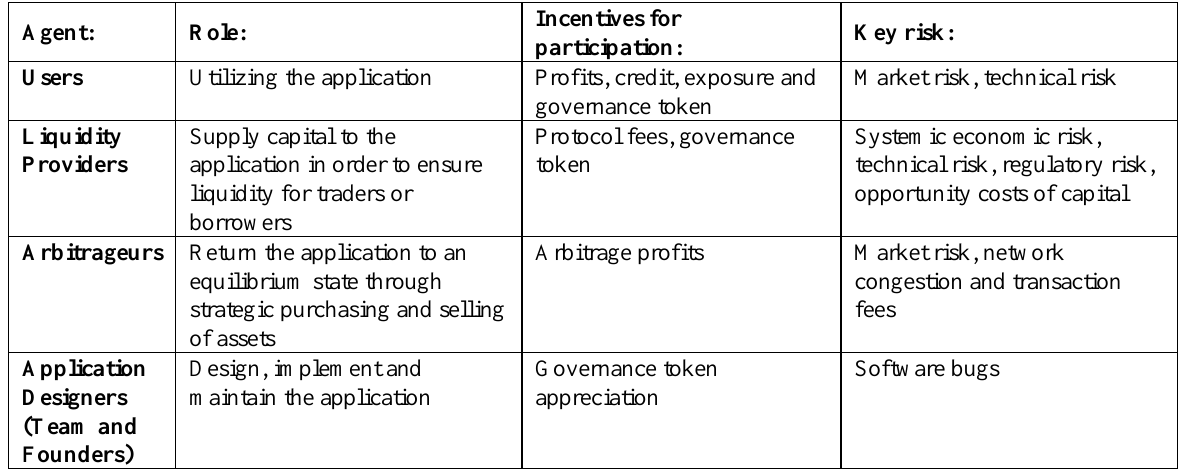
Table 1. Agent classification, incentives, and key